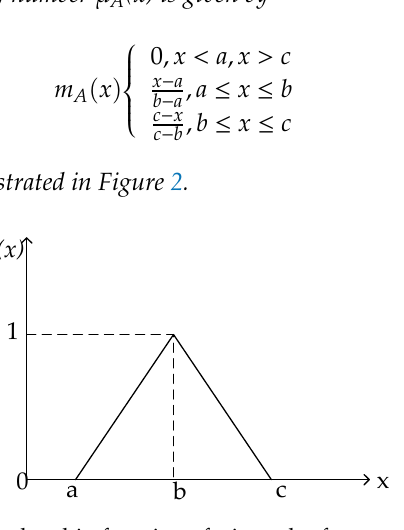
Figure 2. Membership function of triangular fuzzy number A.